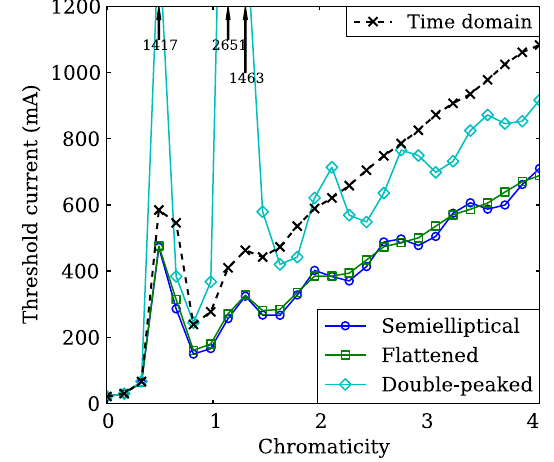
FIG. 4. Threshold current for the coupled-bunch resistive-wall instability for the case with a stationary, lengthened Gaussian bunch. Results of macroparticle simulations in the time domain (dashed line) are compared with those obtained using a frequency domain computation (solid lines).